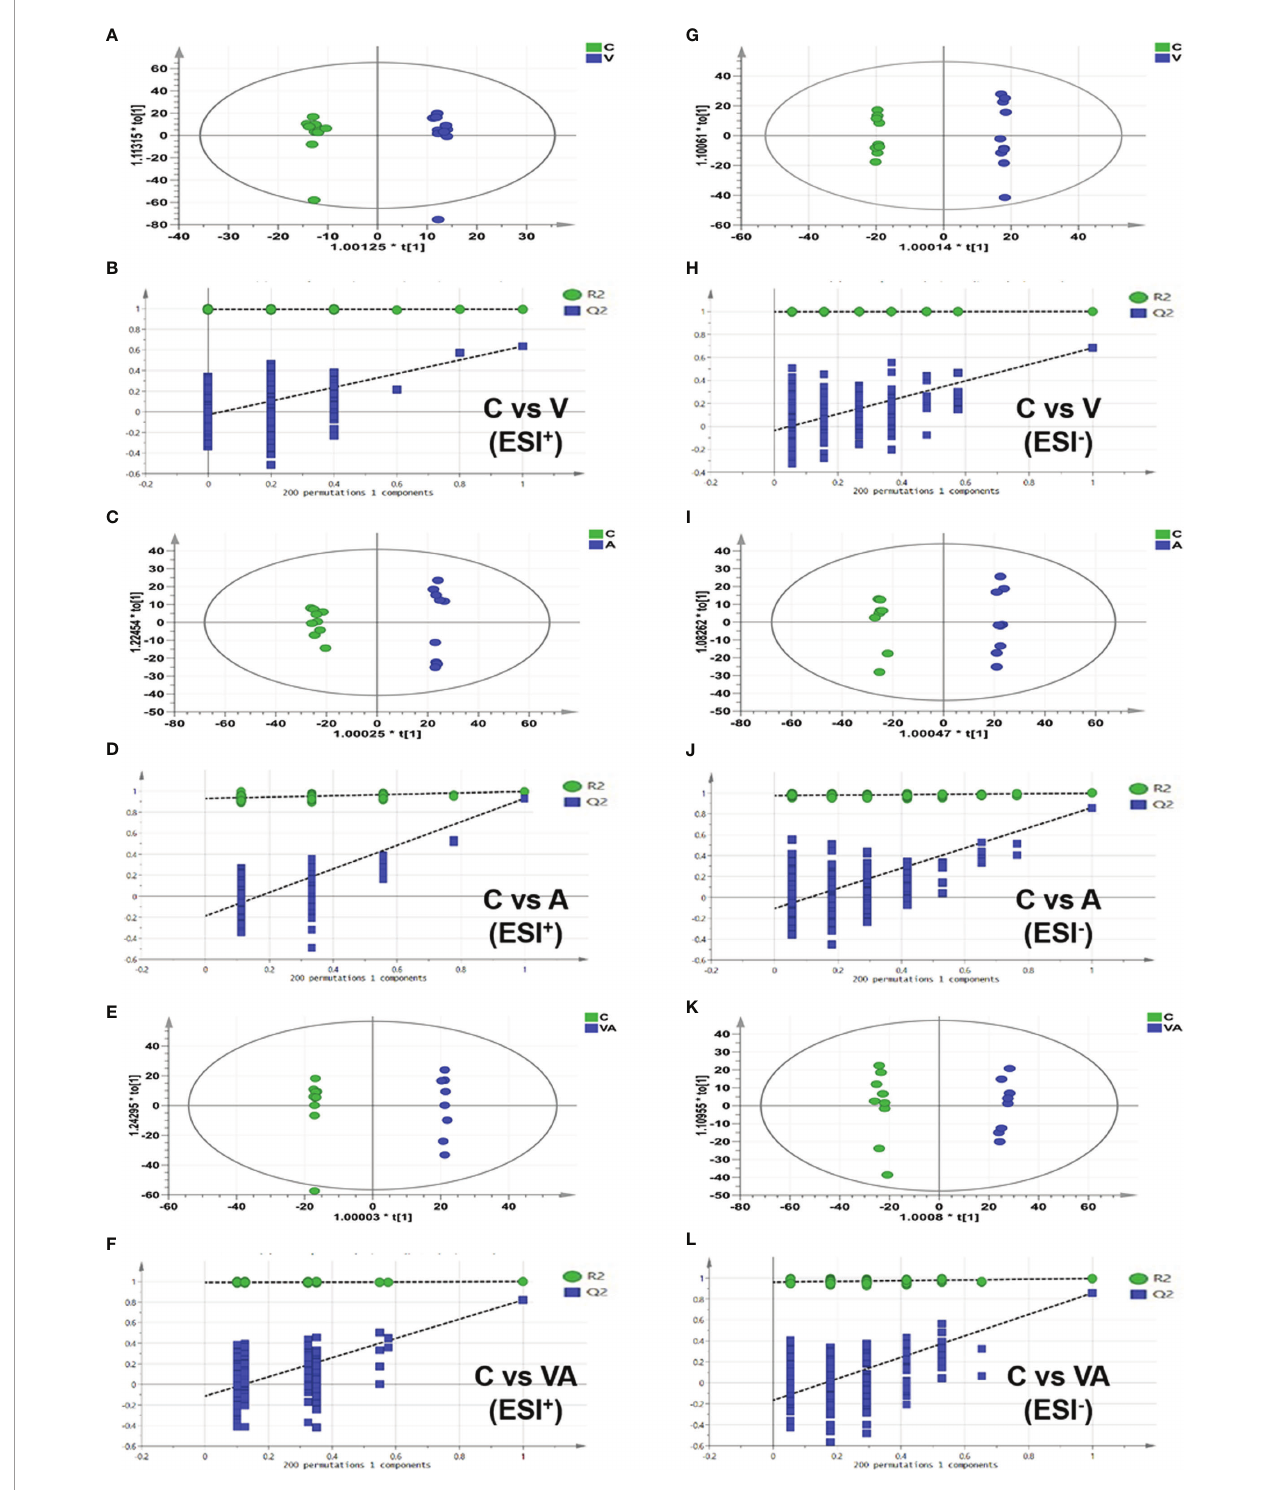
FIGURE 4 | OPLS-DA score plot based on the data of ESI +/ − modes and validations of OPLS-DA models by 200 permutation tests. In ESI + mode: (A, B) group C vs group V, (C, D) group C vs group A, (E, F) group C vs group VA. In ESI − mode: (G, H) group C vs group V, (I, J) group C vs group A, (K, L) group C vs group